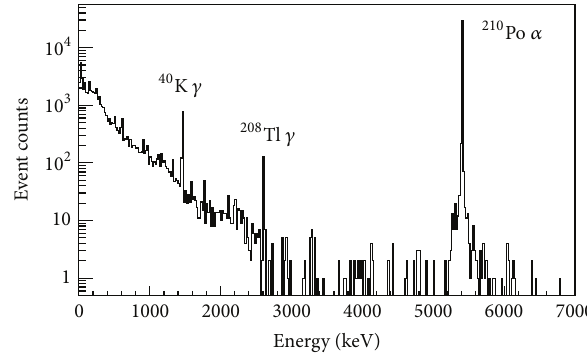
Figure 2: Energy spectrum of background events from one CCVR. The three prominent peaks are the 1461keV 𝛾 -ray line from 40 K decay, the 2615 keV 𝛾 -ray line from 208 Tl decay, and the 5407 keV 𝛼 peak at the 𝑄 -value for 210 Po decay. The 210 Po peak is accompanied by a less prominent peak at 5304 keV which arises because some- times the decay 𝛼 is detected but the corresponding nuclear recoil is not—namely, when the decay occurs on a copper surface facing the detectors. The livetime of this CCVR was 21.5 days, corresponding to 0.17 kg ⋅ y of detector